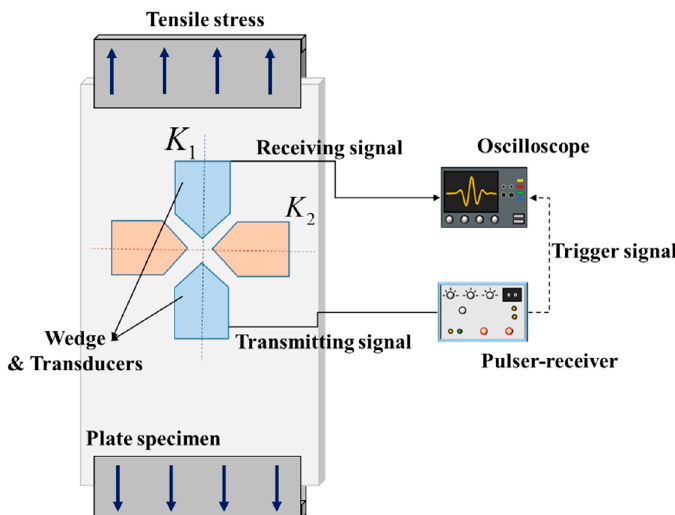
Figure 9. Set-up for acoustoelastic coefficient measurement. The change in surface wave velocity under tensile stress loading is measured. For the measurement of K1 , transducers (blue colored) are placed in the loading direction, while for the measurement of K2 , transducers (orange colored) are placed in the direction perpendicular to the loading direction.